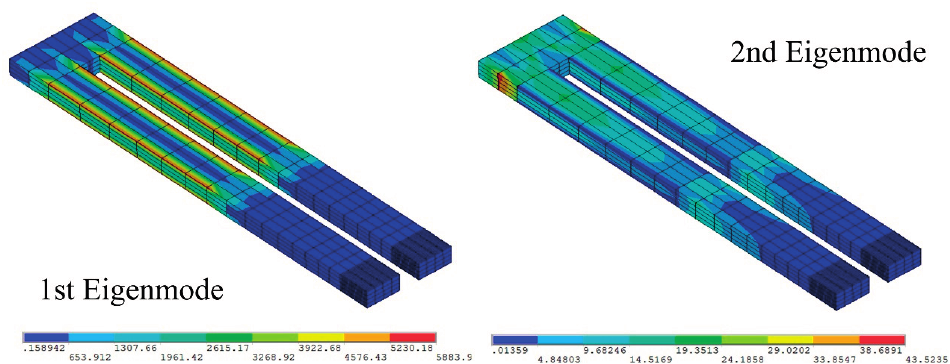
Figure 4. The electric field analysis of the Akiyama probe.